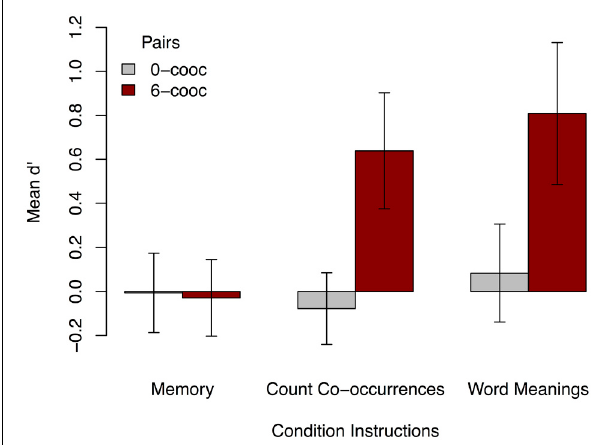
FIGURE 3 | Mean d (cid:2) for 0- and 6-co-occurrence word-object pairings in Experiment 1, by instruction condition. Learners only show significant d (cid:2) for 6-co-occurrence pairs, and only then under the learn word meanings or count co-occurrences instructions. Error bars show 95%